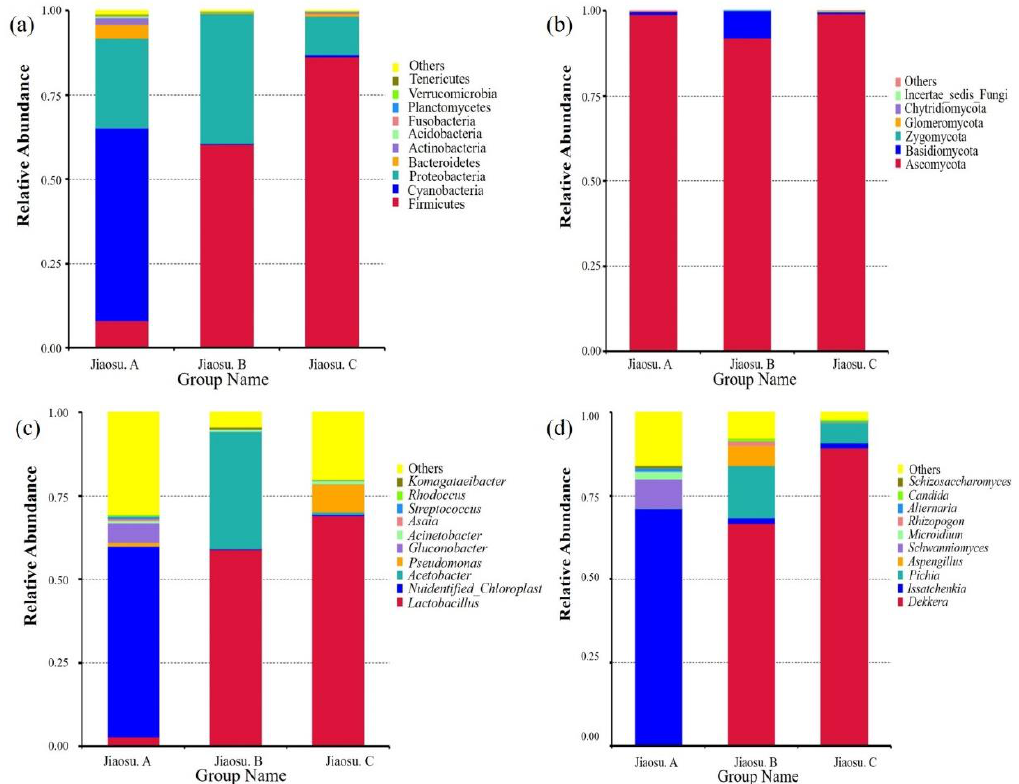
Figure 2. Relative abundance of bacteria ( a ) and fungi ( b ) at the phylum level and bacteria ( c ) and fungi ( d ) at the genus level in all samples. Note: The figure shows only the top 10 for each category (phyla or genera) in terms of relative microorganism abundance.